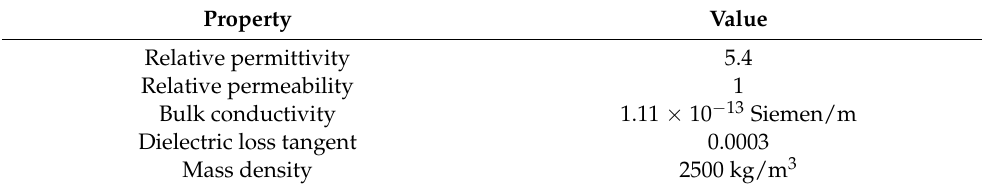
Figure 9. 2D FEA model of the medium-voltage machine. Different parts of the motor are numbered and listed in Table 3. Table 2. Properties of Mica.